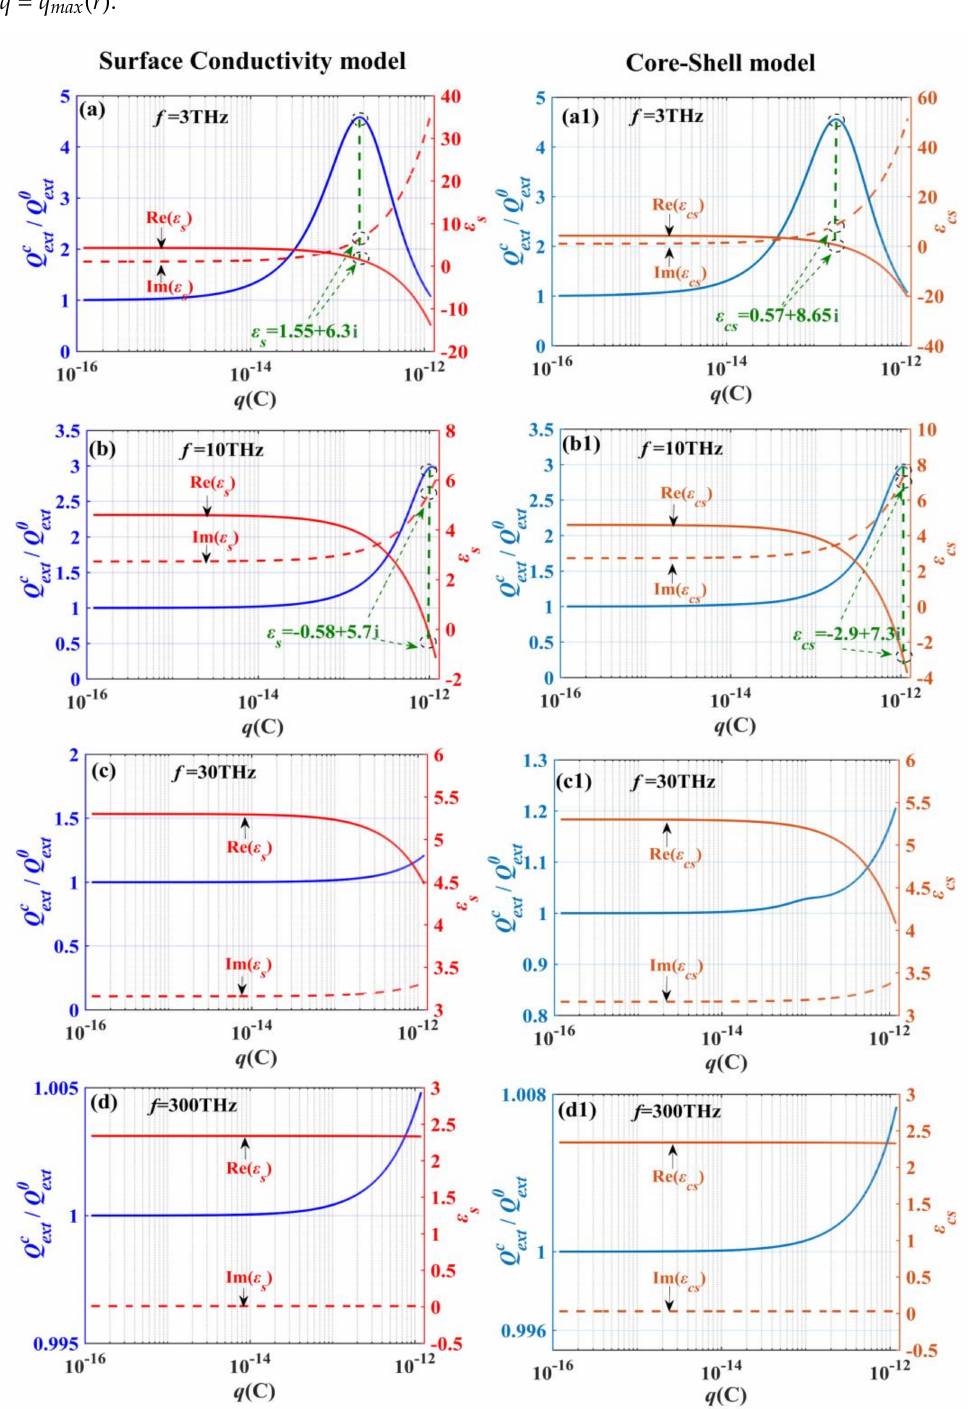
Figure 4. The extinction amplification factor Q c and ε cs ) given by the surface conductivity model ( a – d ) and the Core-shell model ( a1 – d1 ), respectively, which are plotted as functions of q , the total net charge of the particle. Here, the particle radius is 0.5 µ